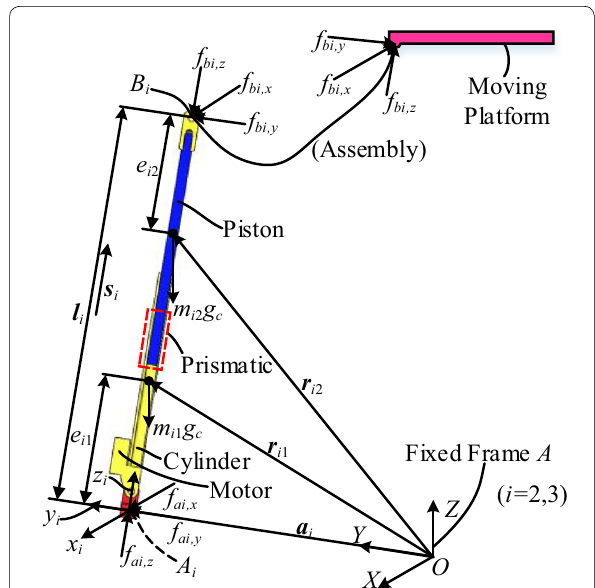
Figure 13 Free-body diagram of the i th actuating